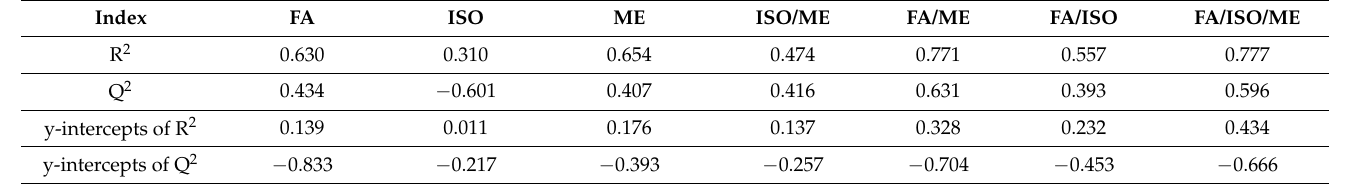
Figure 5. OPLS-DA score plots of the Ningxia samples obtained by a chemical analysis of: ( A ) Mineral elements; ( B ) Isotopes; ( C ) Fatty acids; ( D ) Fatty acids combined with mineral elements. Table 6. Characteristics of OPLS-DA models of milk in the Ningxia Hui autonomous region.